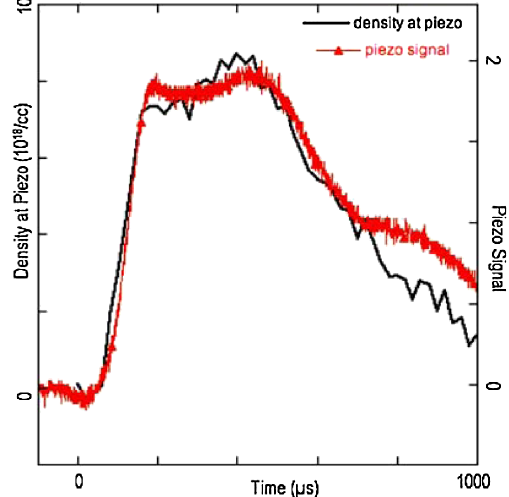
FIG. 18. Comparison of piezopressure vs time signal with density data derived from the laser interferometer.